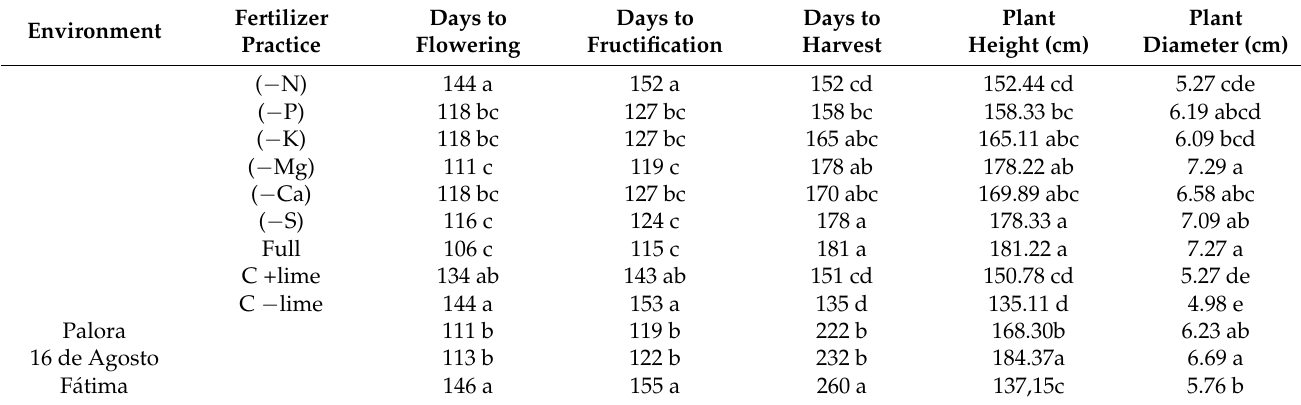
Table 5. Mean values of physical and phenological